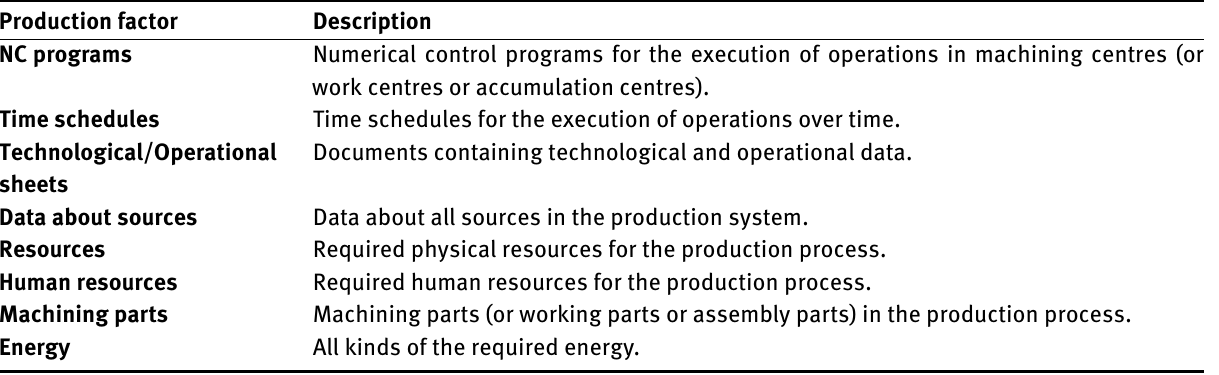
Table 1: Defined input data of the production